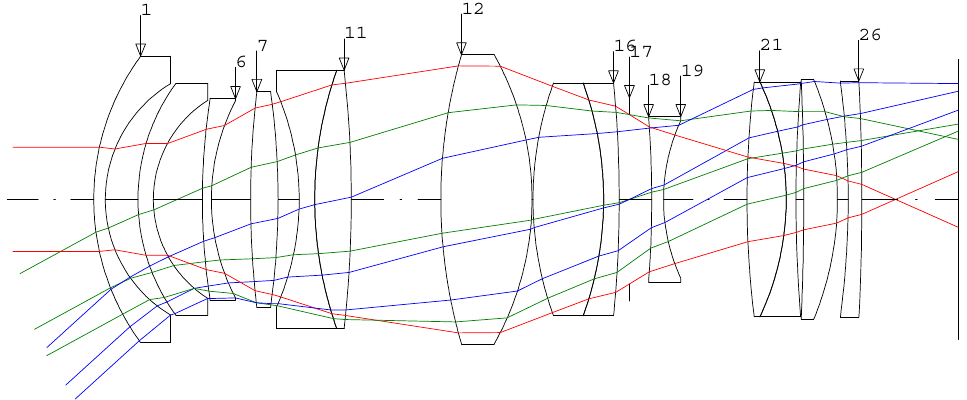
Figure 5. Optical layout of the optical system with 24 mm EFL increment.